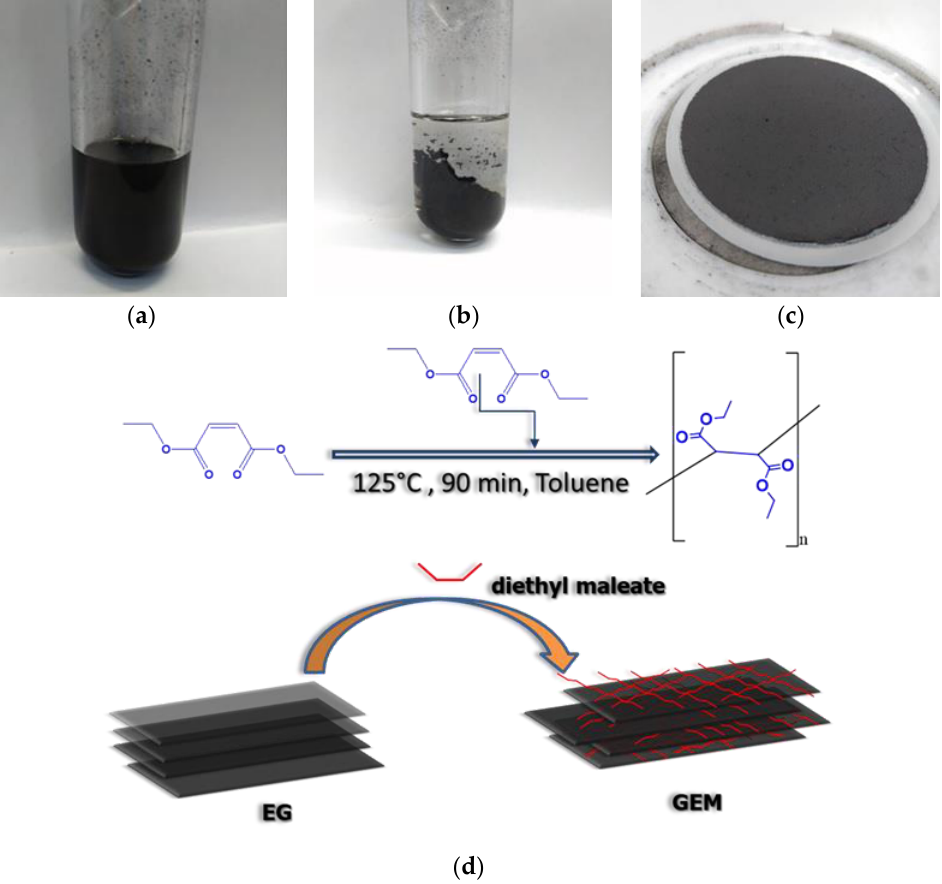
Figure 1. Graphene before ( a ) and after ( b ) microwave reaction. The sample was filtered with an alumina membrane ( c ). Reaction scheme and graphical representation of polydiethylmaleate on the exfoliated graphene surface ( d ).